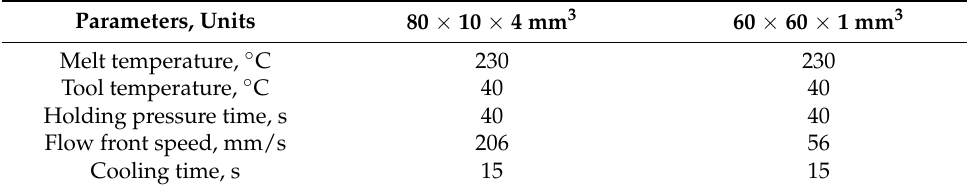
Table 3. Injection-molding parameters for producing specimen. Parameters,